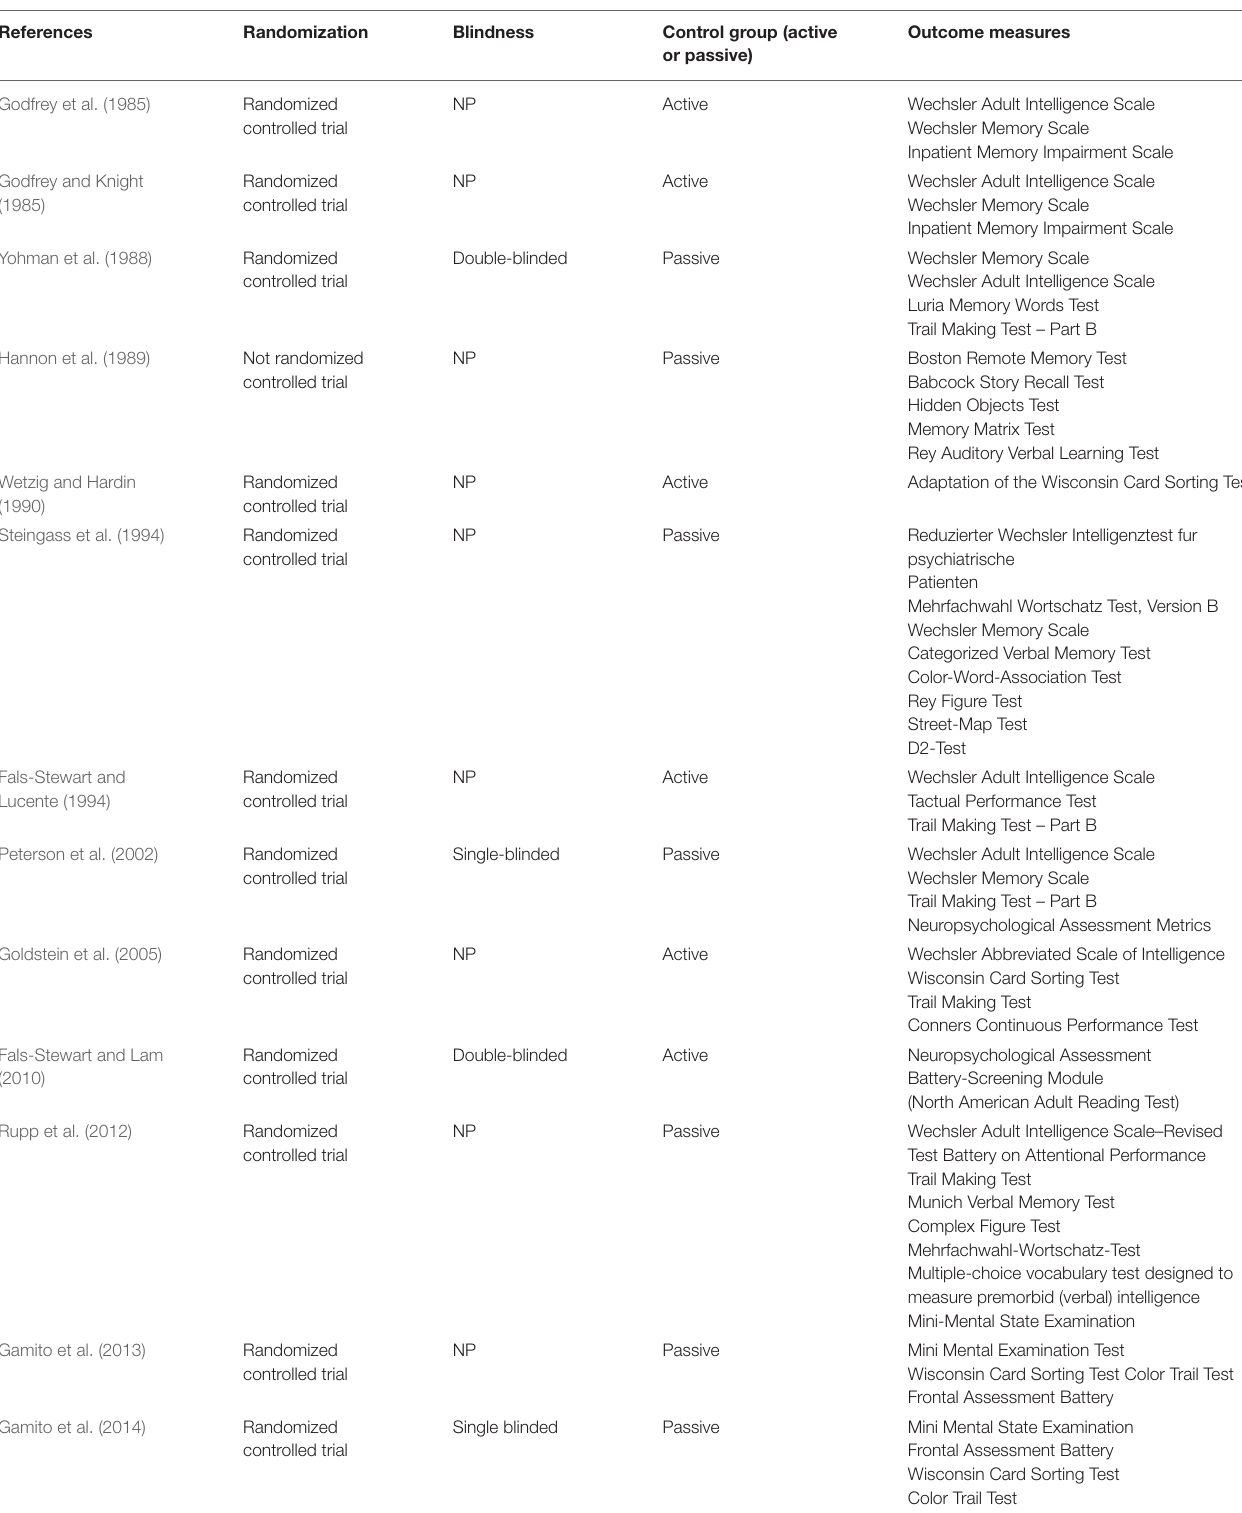
TABLE 2 | Study characteristics.